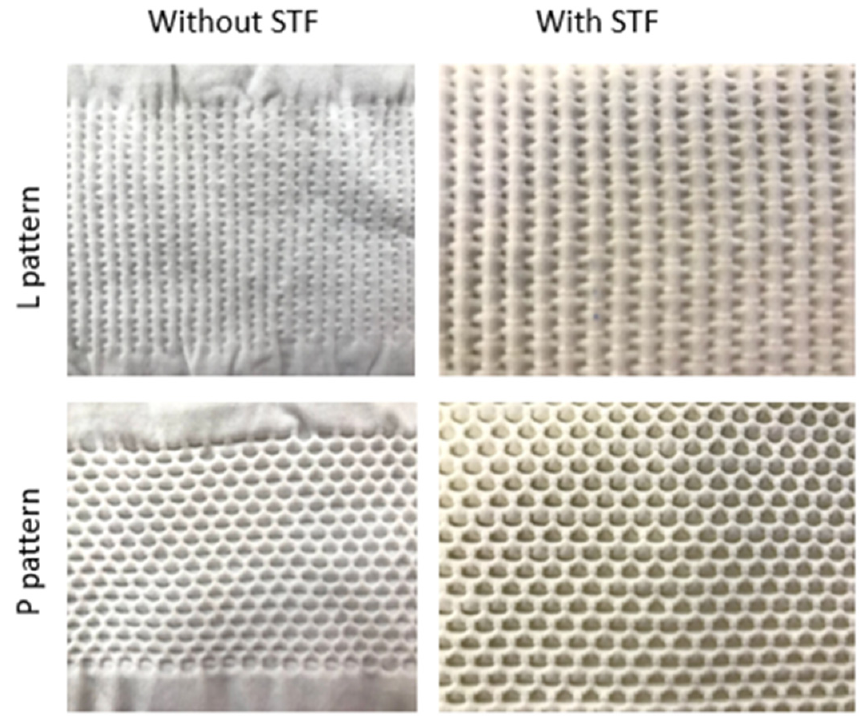
Figure 5. Knits with L and P patterns, with and without STF. Once more, tensile tests were performed to see the mechanical behaviour of the samples. However, in this turn, the absorbed energy was also calculated to see the potential of the obtained materials to be applied in protective applications. The materials’ ability to absorb energy is important in protection products due to the increase in the distribution of loads throughout the hierarchical architecture [20]. The graphical results obtained by knits with the L and P patterns are represented in Figures 6 and 7, respectively. When performing the tensile tests, it was observed that the knits impregnated with STF could stretch more. This higher stretch capability boosts the achievement of higher absorbed energy values. It was observed that when knits were combined with STF, higher maximum force and absorbed energy values were obtained. The only exception was the P pattern in the course direction. However, the incongruity of this sample was already mentioned in the analysis of the mechanical behaviour of the knits without STF. When comparing the L and P pattern, it is observed that the P pattern has higher energy absorbed values, making the knits stand out where denser PA was applied. This result follows the ones mentioned before, where it was concluded that applying higher amounts of mass in the same area unit increases the capability of the samples to support higher forces in the tensile movement. Moreover, as a consequence of this property, the samples with denser material will have the ability to absorb higher amounts of energy and much more potential to be applied as a protective material/product. Yan et al. also studied the influence of material density on protective applications’ performance. In the mentioned study it was observed that when materials have higher densities they can reach higher forces when burst and puncture tests are performed. The higher amount of fibers and bonding points per unit of the area of materials with higher densities are the reasons given in the study for achieving higher mechanical behaviours